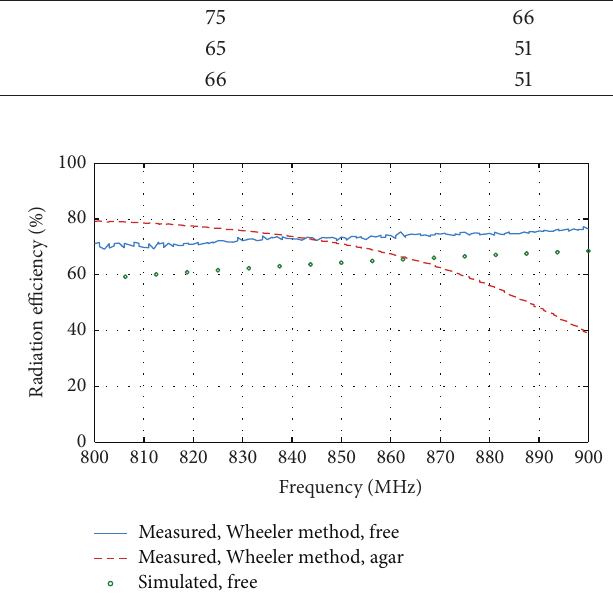
Figure 5: Simulation and measurement of the radiation efficiency of the vertically folded coupled patches tag antenna.